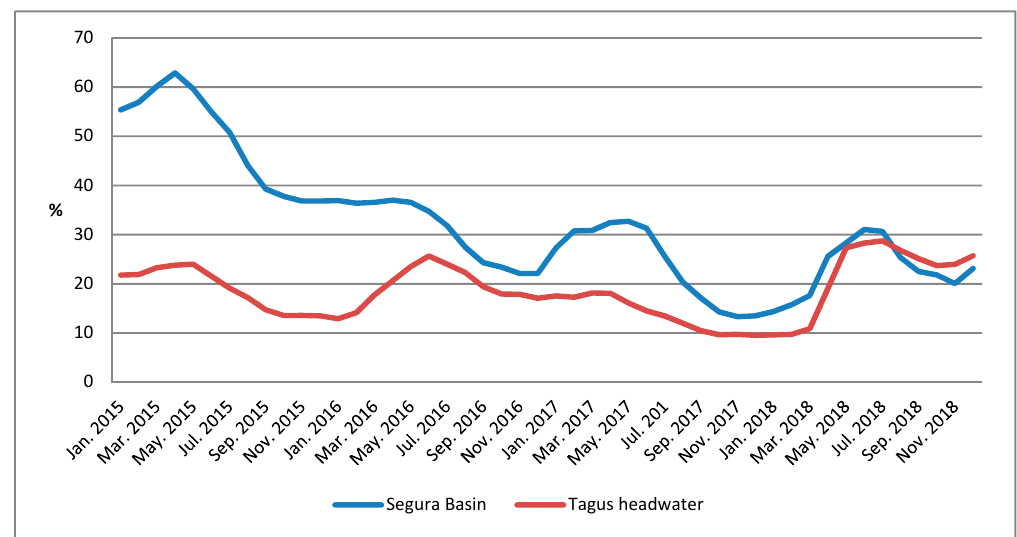
Figure 4. Water stored (%) in the Segura Basin and in the Tagus headwater (January 2015–December 2018) Source: Ministerio para la Transición Ecológica [55]. Own elaboration.